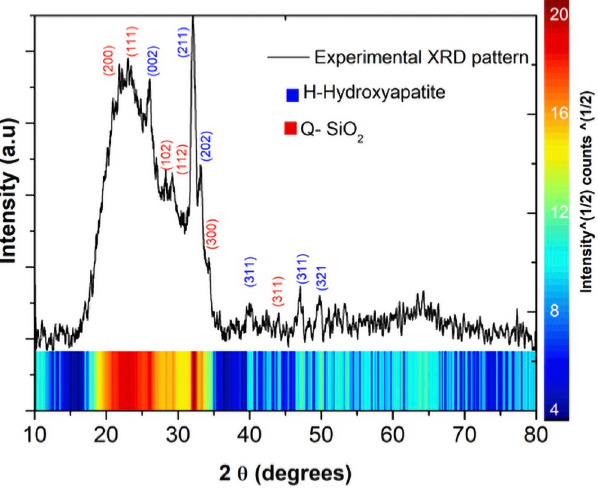
Fig 3. XRD pattern for the SiO 2 -HA composite membrane sintered at 800˚C, where (H) Hydroxyapatite and (Q) Silica are noted.